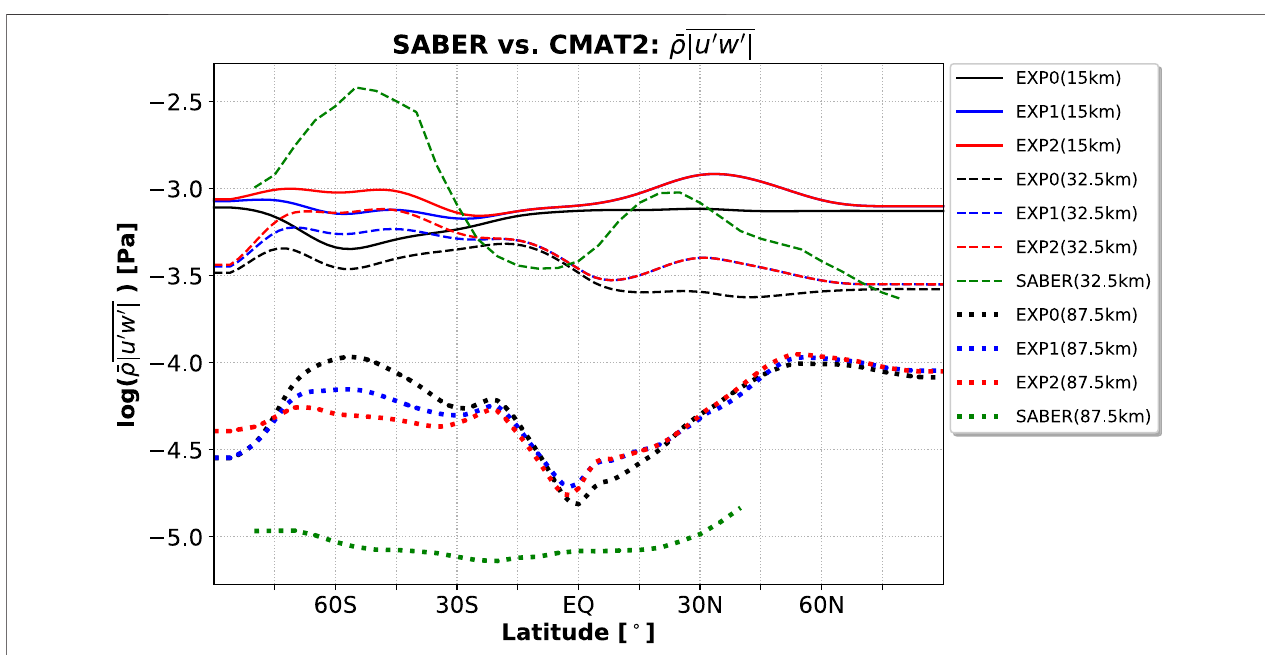
FIGURE 3 | Comparison of the modeled zonal mean total absolute horizontal momentum fl ux among the different experiments and SABER at 15 km (solid line), 32.5 km (dashed), and 87.5 km (dotted). The model simulations, EXP0 (black), EXP1 (blue), and EXP2 (red), are represented by different colors.